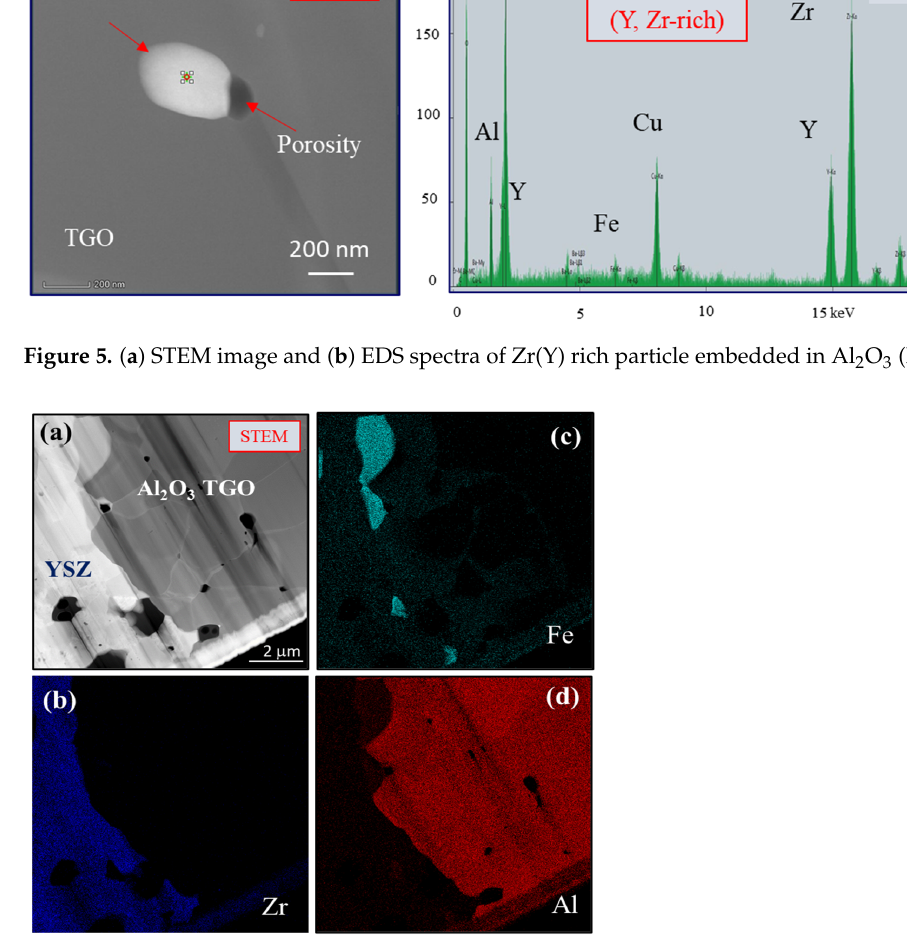
Figure 6. STEM image ( a ) of the TBC/TGO interface (I): elemental rasters ( b – d ) show Fe-rich particles at interface (500 h at 1300 °C).